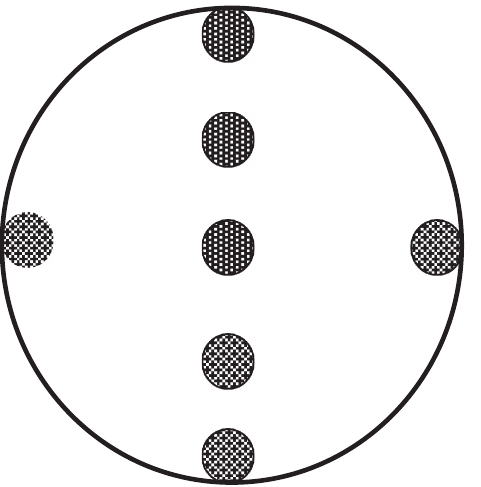
Figure 1: Location of samples from transverse section of EB Nb ingot for chemical analysis.